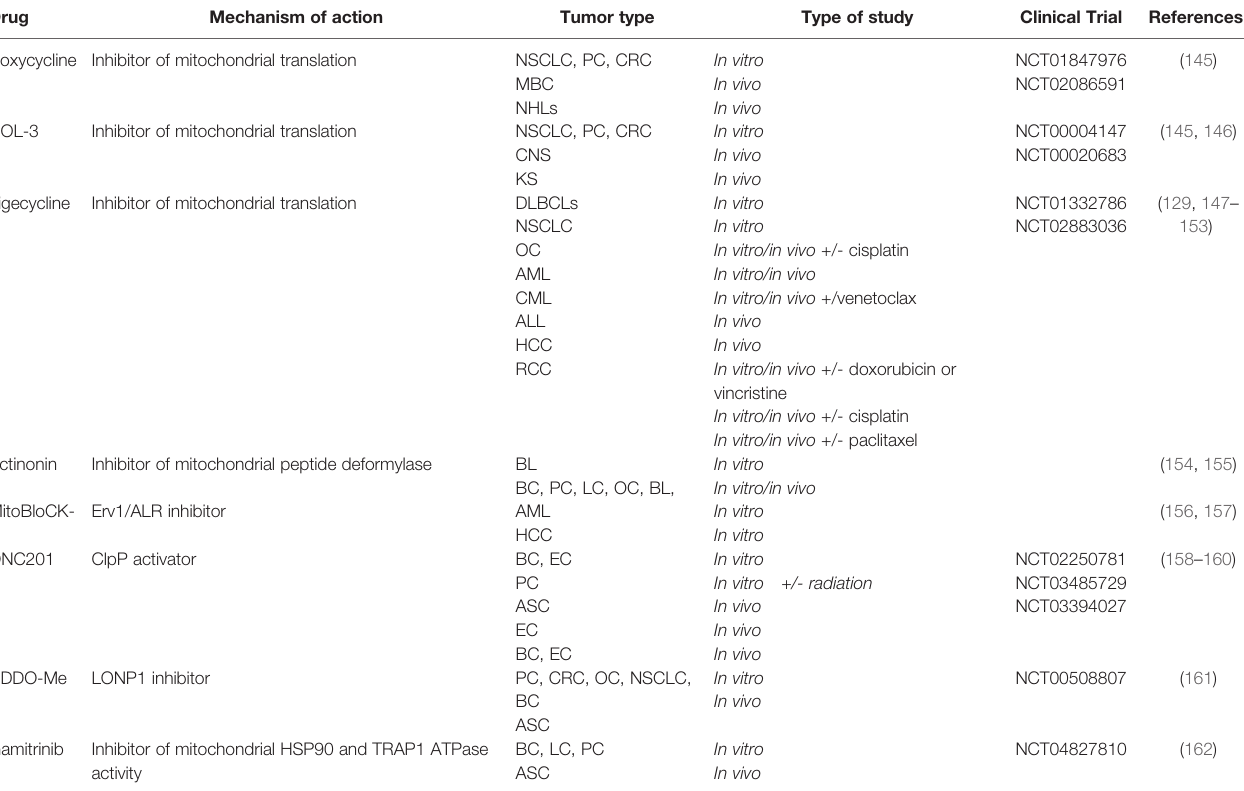
TABLE 1 | List of mitochondrial proteostasis targeting agents used as anticancer drugs in preclinical and clinical studies.